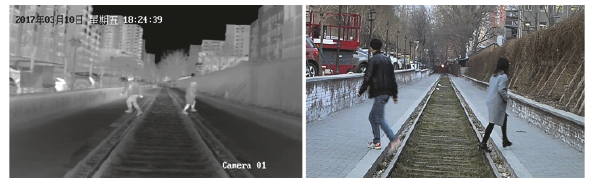
Figure 9: Infrared and visible images.